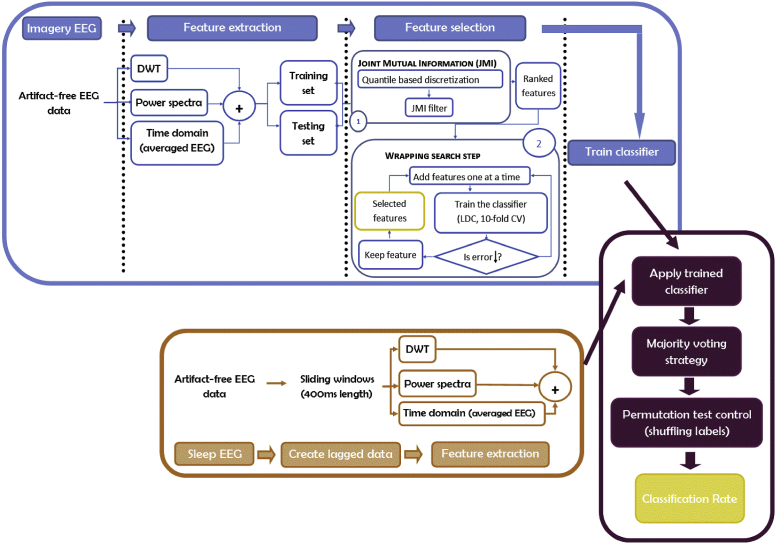
Flow diagram of the classifier pipeline. We trained the classifier with EEG data from the wakeful imagery task (bluish colours), next we used EEG data from sleep (orange colours) to feed the trained algorithm and calculate the final accuracy results (purple colours). From the imagery data we extracted 3 types of features (temporal, spectral and wavelet-based features) that divided into training and testing sets were used to train the classifier after a selection process to reduce the number of features. The ranking and selection of features was done using join mutual information (JMI) algorithm and a wrapping methodology. Once the classifier (LDC) was trained we extracted the same type of features from the sleep dataset and used them to feed the trained classifier. An additional control step (permutation of labels) was added to be sure that the classification rates were not due merely to the chance probability.